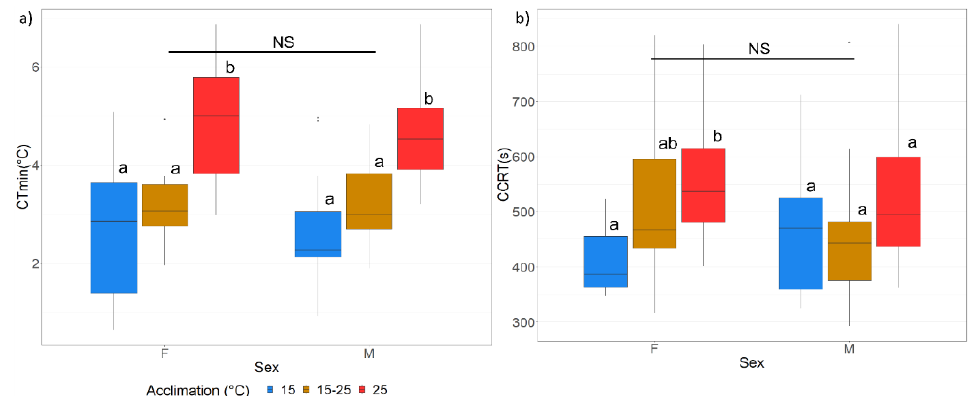
Figure 2. ( a ) Boxplot indicating median CT MIN (°C), upper and lower quantiles and maximum and minimum values (whiskers) for adult males (M) and females (F) from larvae exposed to the three acclimation temperatures (15 °C, 15–25 °C and 25 °C); ( b ) Boxplot indicating median CCRT (s), upper and lower quantiles and maximum and minimum values (whiskers) for adult males (M) and females (F) emerging from larvae exposed to the three acclimation temperatures (15, 15–25 and 25 °C). Significant differences between sexes are indicated as: * = p < 0.05, ** = p < 0.001, *** = p < 0.0001, NS = not significant. Different letters indicate significant differences between acclimation groups per